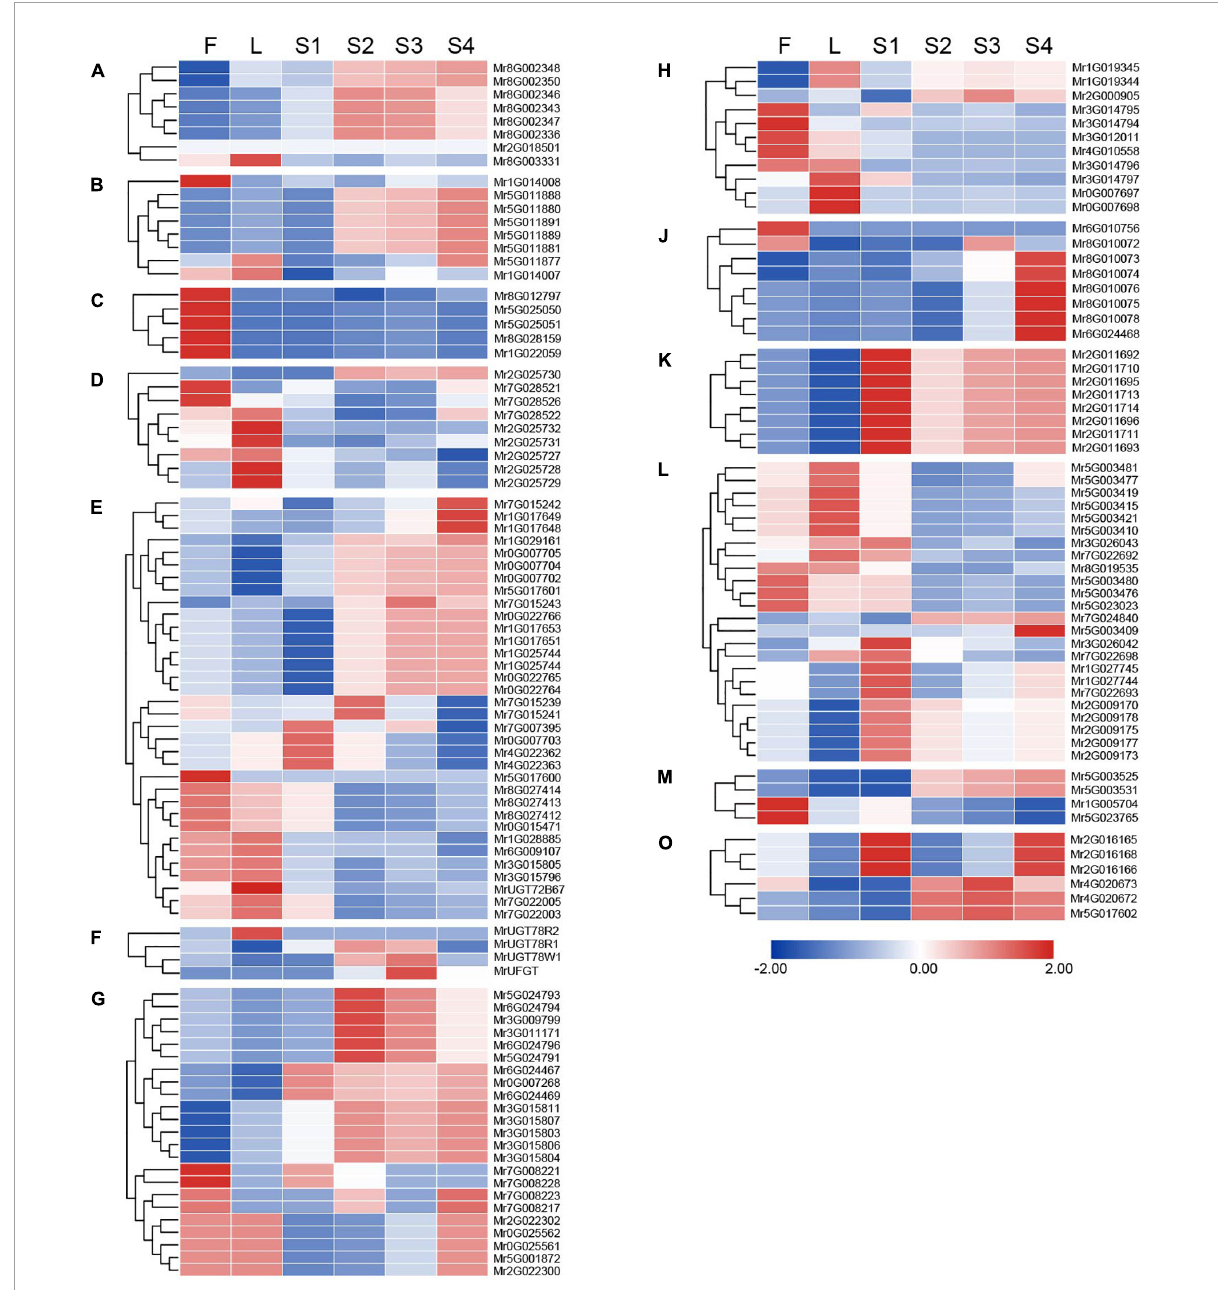
FIGURE4 Expression pattern of MrUGT genes in different tissues of Morella rubra . Expression of MrUGT genes in flowers (F), leaves (L), and fruit development (S1–S4) are shown. Color scale represents –2 to 2. (A–H) , (J–M) , and (O) mean different phylogenetic groups of MrUGT